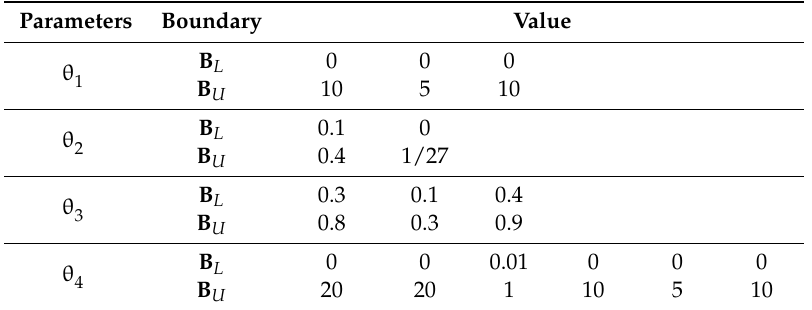
Table 6. The boundaries of each optimized parameter.